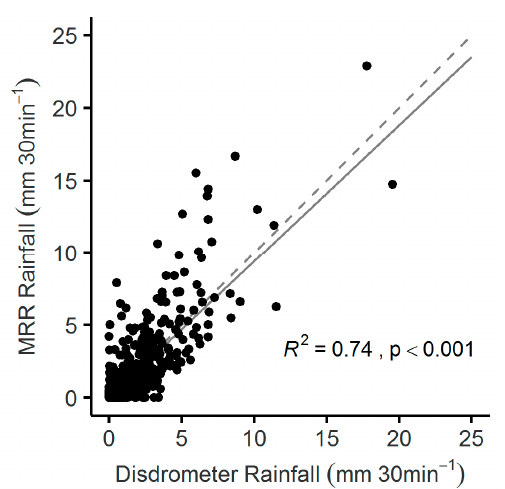
Figure 2. Correlation between rainfall recorded by the Micro Rain Radar (MRR) and Laser Precipi- tation Monitor (LPM) data at 30-min accumulation. The solid line denotes the regression line, the dashed line denotes the bisector line, and R 2 is the determination coefficient.